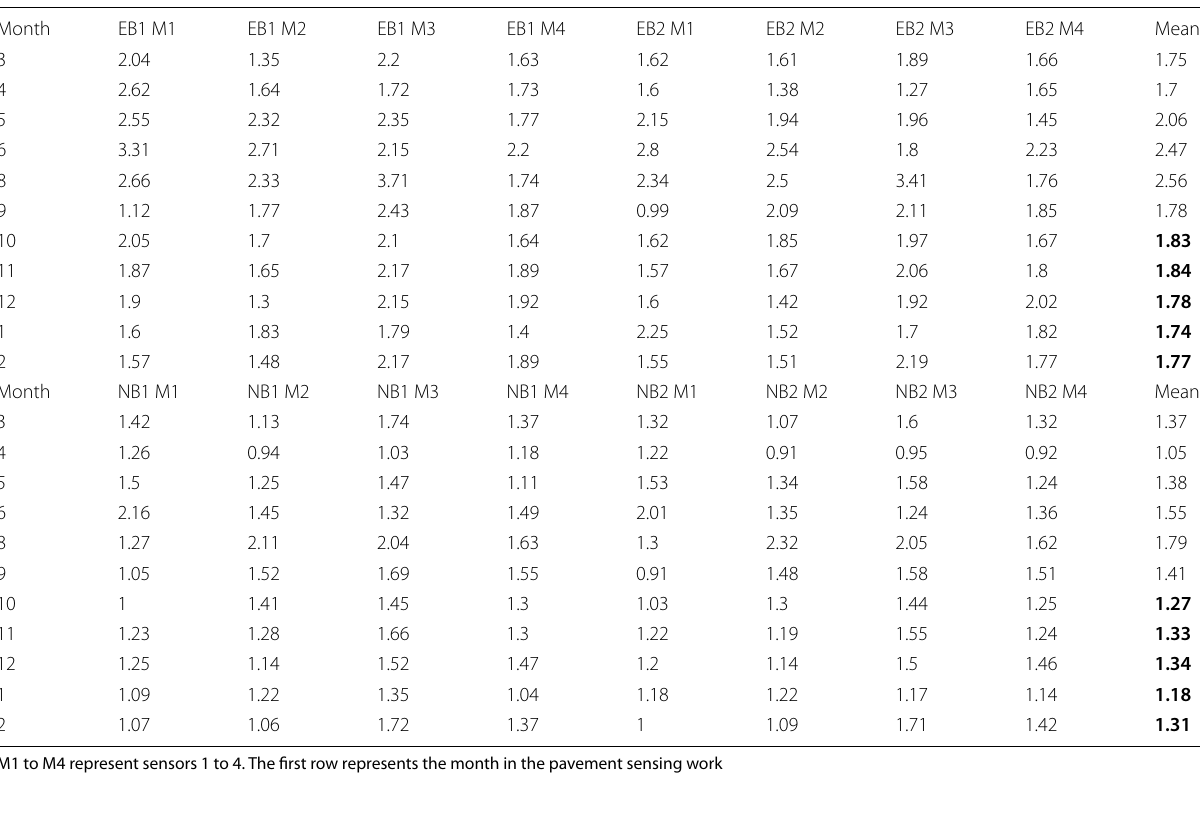
Table 8 Summary of threshold values